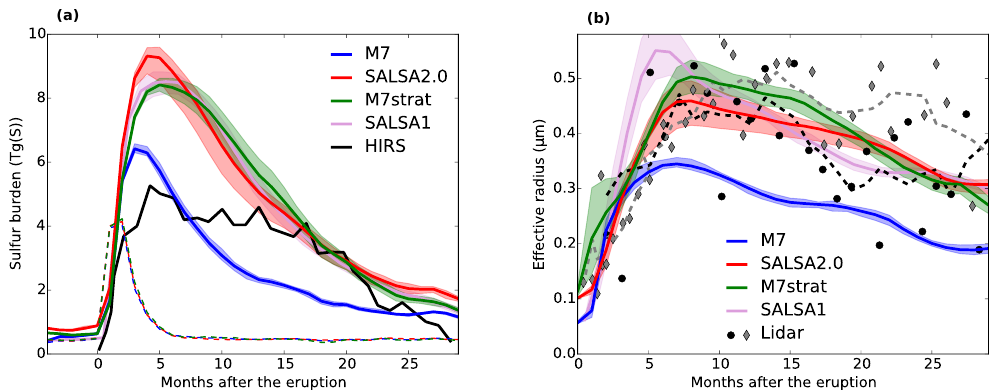
Figure 16. (a) The simulated global burden of SO 2 (dashed curves) and sulfate (solid curves), simulated by SALSA2.0 (red curves), M7 (blue curves), M7strat (green curves), and SALSA1 (purple curves). The black curve shows the global sulfate burden retrieved from HIRS observations. (b) The mean effective radius of stratospheric aerosol in the 12 to 20km layer observed by Raman lidar (diamond markers represent the observations at Laramie, circles represents those at Geesthacht, and dashed lines show the 5-month running means), simulated by SALSA2.0 (red curves), M7 (blue curves), M7strat (green curves), and SALSA1 (purple curves). The shading around the solid curves represents the variability of the model